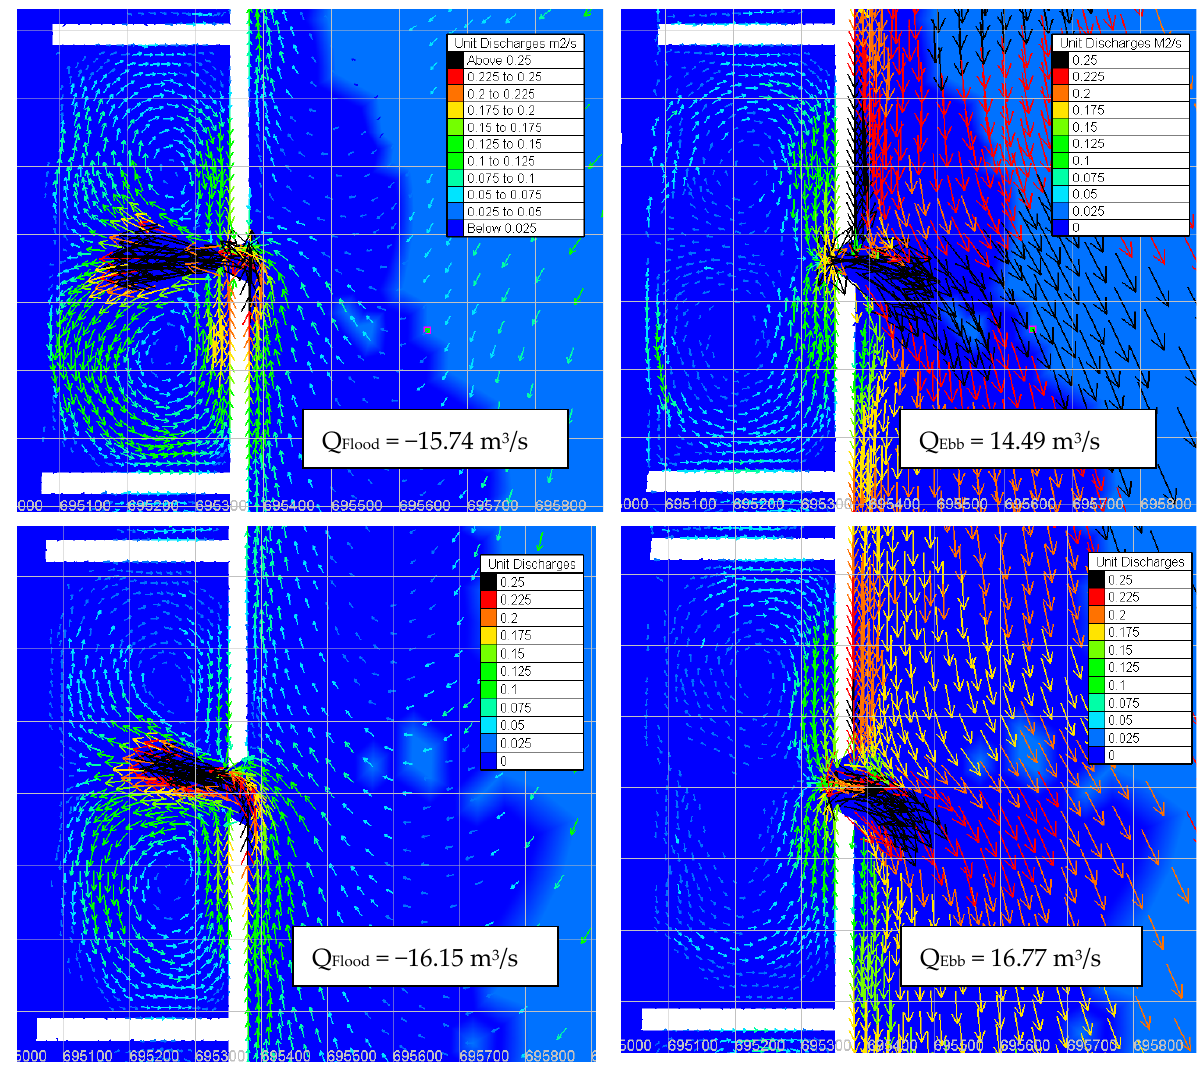
Figure 11. Fields of half-tidal-cycle-averaged unit discharges: flood flow ( Left ) and ebb flow ( Right ); Top : KB1—gap of 30 m, Bottom : KB3—gap of 70 m.